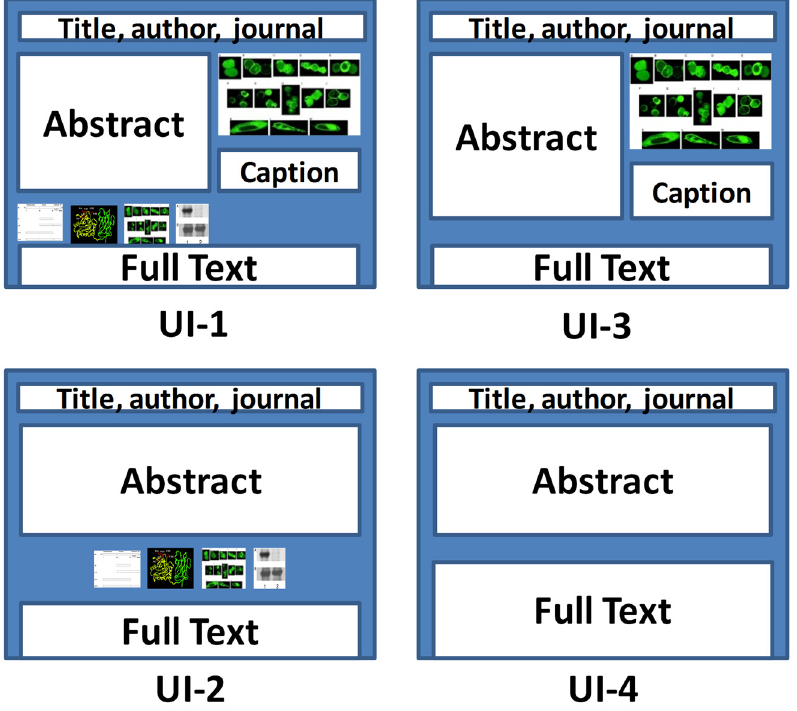
Figure 7. Figure-ranking user interfaces evaluated. UI-1 shows the most important figure enlarged and thumbnails of other figures. UI-2 shows figure thumbnails. UI-3 shows the most important figure only, enlarged. UI-4 shows the full-text article. The full-text article can be accessed from all four UIs.